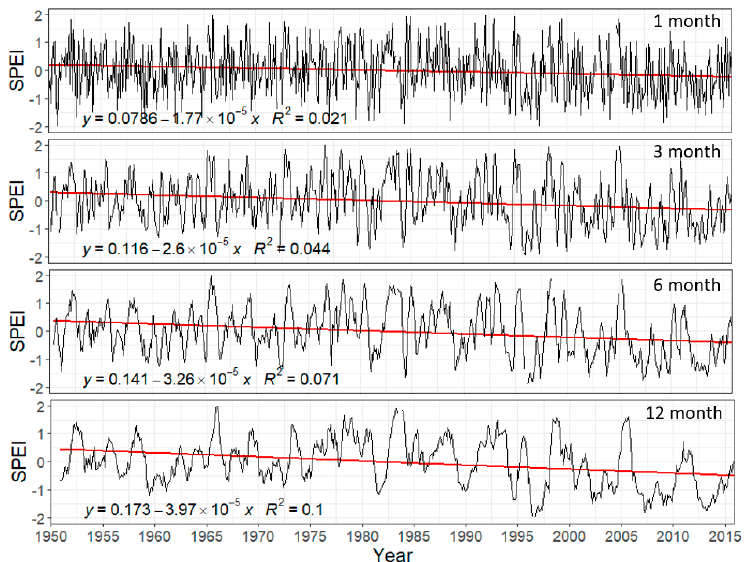
Figure 4. Time series of the spatial mean of 1-, 3-, 6-, and 12-month Standardized Precipitation Evapotranspiration Index (SPEI) timescales for a period of 1950 January to 2015 December significant at p ≤ 0.05 of the Mojave Desert (Global Drought Monitor SPEI data [31]). Trends in other ecoregions were similar (data are shown in Appendix A Figures A2–A4). Table 1. The linear trend output of SPEI significant at p ≤ 0.05 from 1950 January to 2015 December for all ecoregions using the ecoregion scale SPEI data obtained from Global Drought Monitor [31].